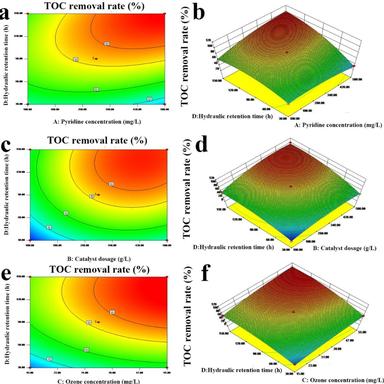
Response surface and counterplots for TOC removal from pyridine wastewater. Effects of process parameters on the removal of TOC: pyridine concentration and hydraulic residence time (a and b); catalyst dosage and hydraulic residence time (c and d); and ozone concentration and hydraulic residence time (e and f).